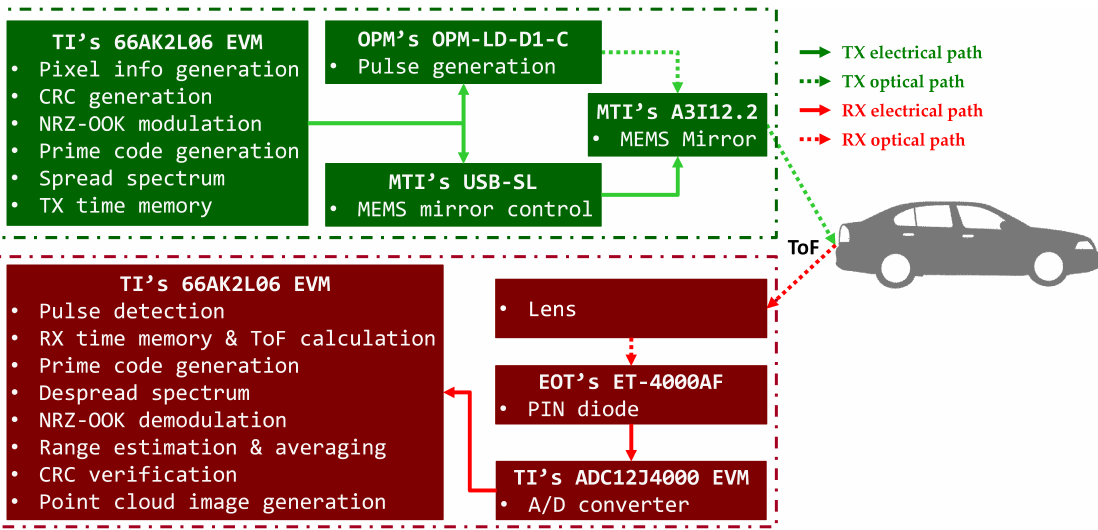
Figure 2. Prototype LIDAR system comprising commercial off-the-shelf products.